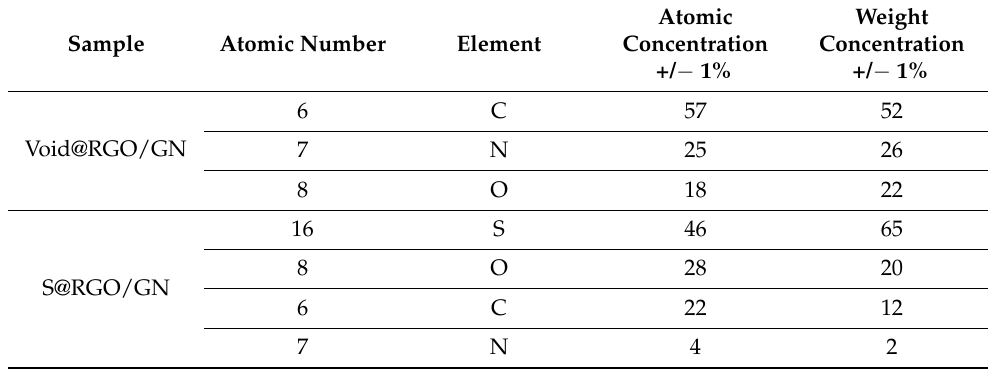
Table 1. Energy-dispersive X-ray results of Void@RGO/GN and S@RGO/GN.